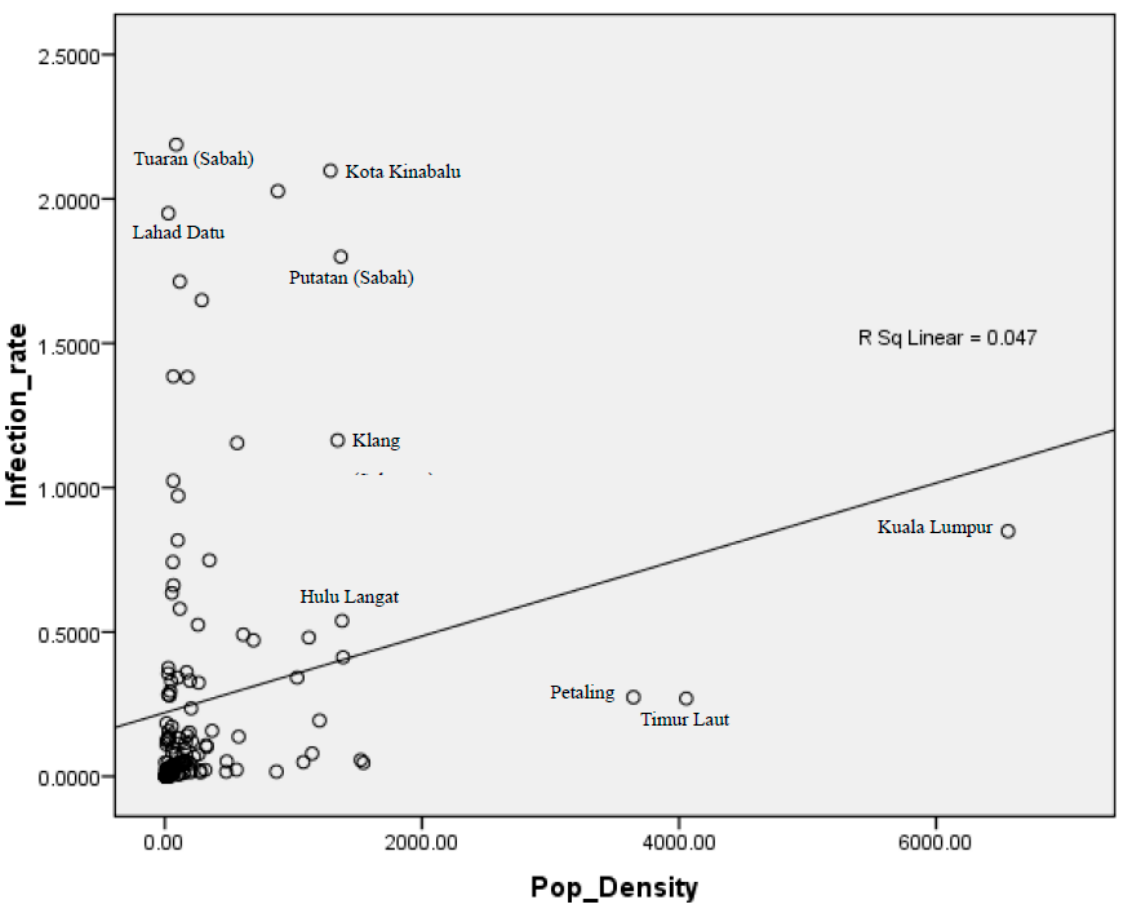
Figure 3. Analysis revealed a moderately strong relationship between population density and COVID-19 infection rates in 2020. The model revealed an R-value of 0.216 and an R 2 value of 0.047.